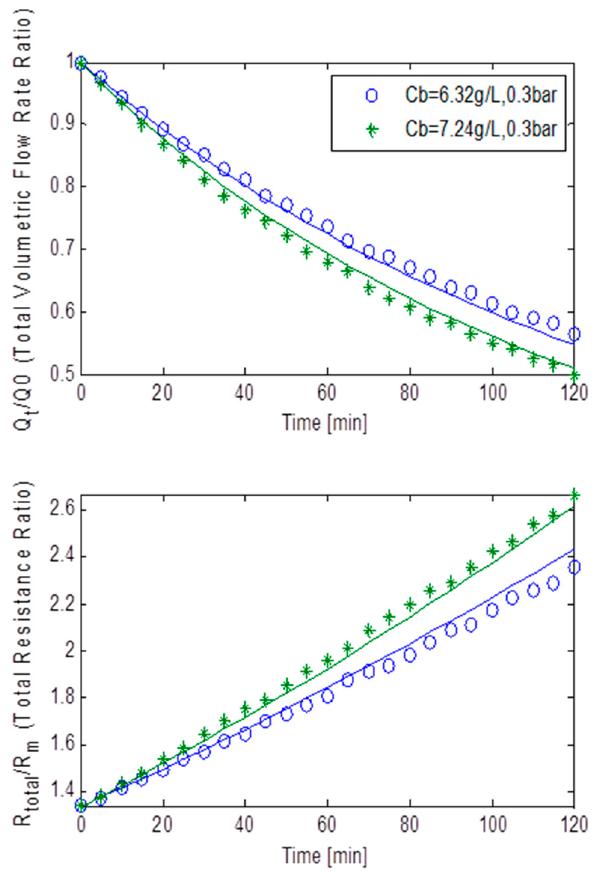
Figure 10. Flux decline and total resistance for TMP step of 30 kPa for the static square-shaped MBR system with best model fits.